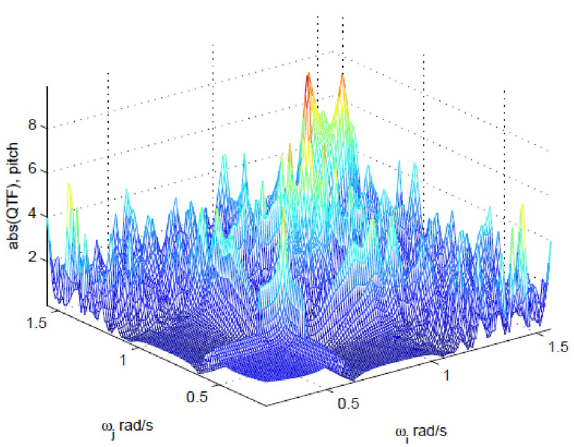
Figure 2. Non-dimensional pitch QTF absolute value, using MATLAB, www. mathw orks.